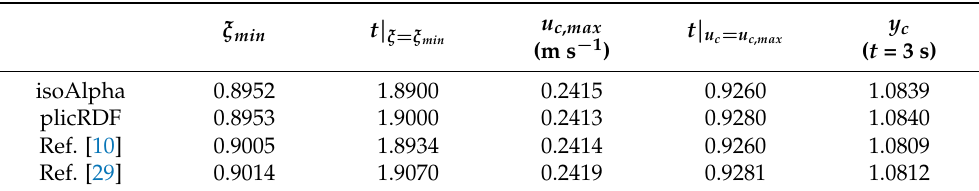
Table 5. Benchmark results for C1 case (M3 mesh) for both isoAlpha and pliRFD method compared with Refs.